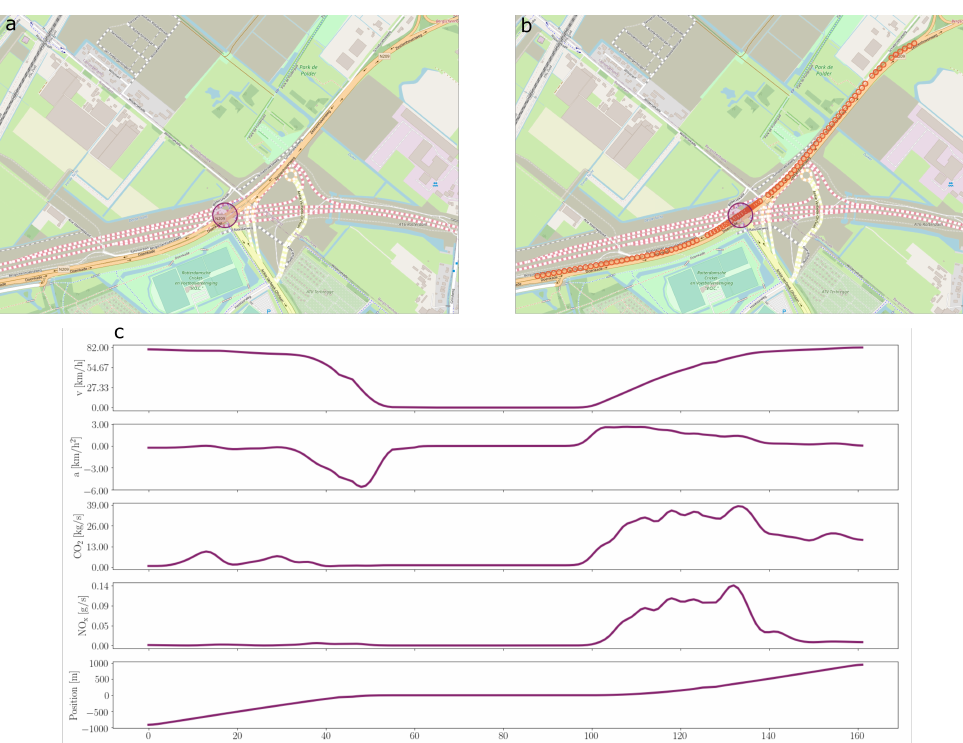
Figure 2. Example of the extraction of the data around the intersections. ( a ) Signalized intersections were identified on the map. ( b ) The fragment of length 2km symmetric around the intersection was selected based on the position data. ( c ) All the time series relevant for this study were gathered; from top to bottom, the velocity, acceleration, instantaneous CO 2 , and the instantaneous NO x . At the bottom, the position of the vehicle relative to the stop line is plotted for reference. There is a period between 60 to 100s in which the vehicle is waiting at the traffic light. Around 100s is when the vehicle starts moving. Data spans only until the vehicle is 1000m past the